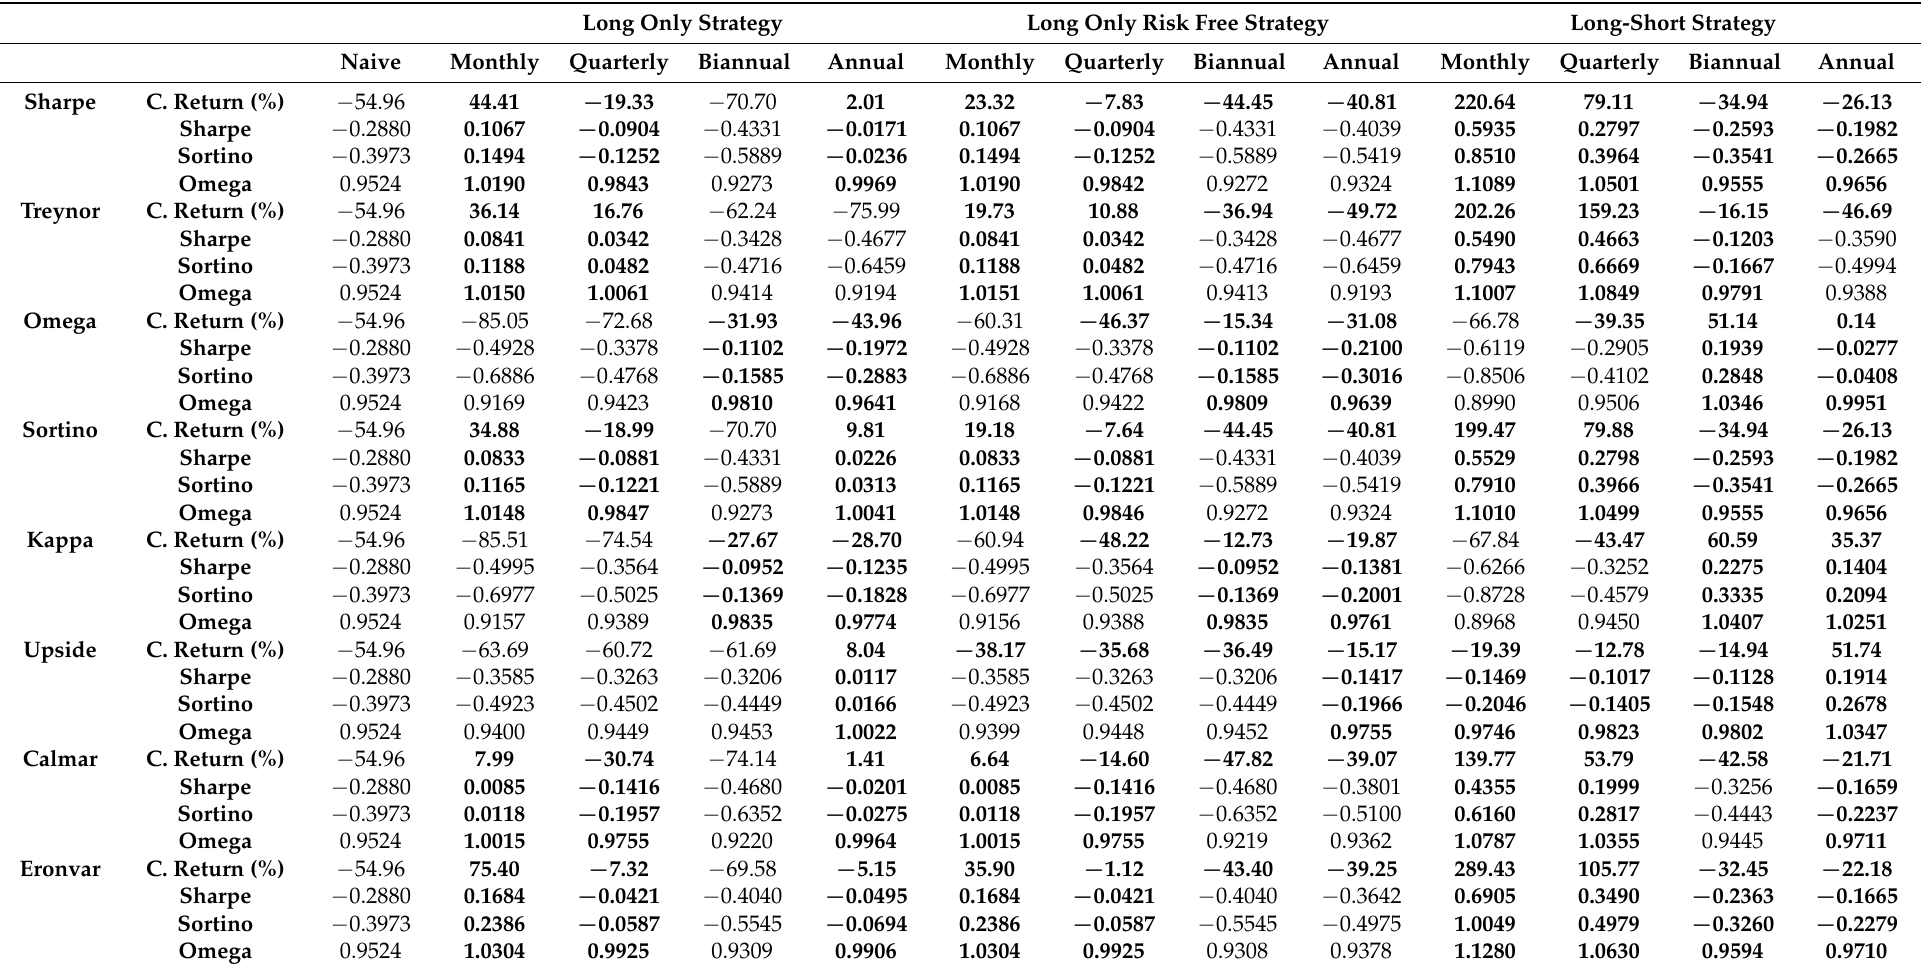
Table 3. Performance evaluation from the